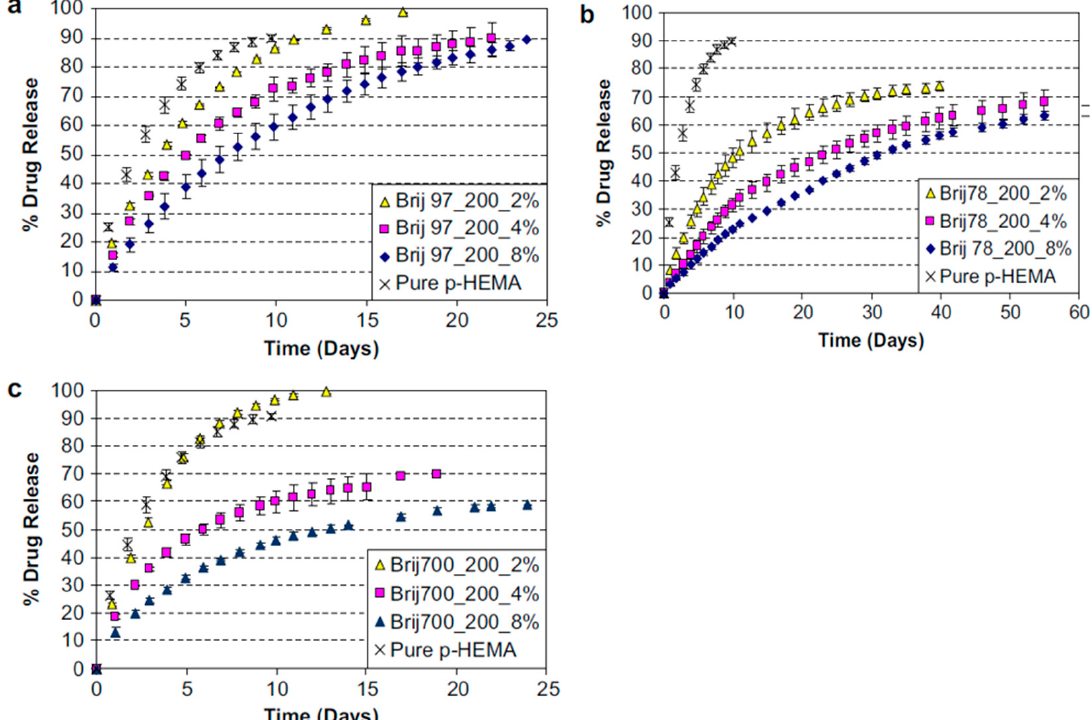
Figure 4. Influence of surfactant on cumulative release of CsA (50 mg/contact lens). The contact lenses consisted with different surfactants: ( a ) Brij 97, ( b ) Brij 78, and ( c ) Brij 700. Adapted from reference [86]. Copyright 2008 Elsevier.